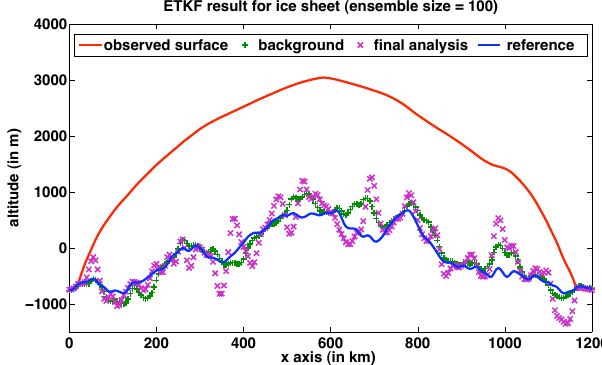
Fig. 13. Absolute difference between analysis and reference (in pur- ple x) after 20 years of the 1000-member ETKF with a slight infla- tion of 1.01 is compared to the absolute difference between back- ground and reference (in green crosses) for bedrock topography. The average RMS error (14.0m) and the maximum absolute differ- ence (47.8m) are improved compared to the result obtained without inflation.